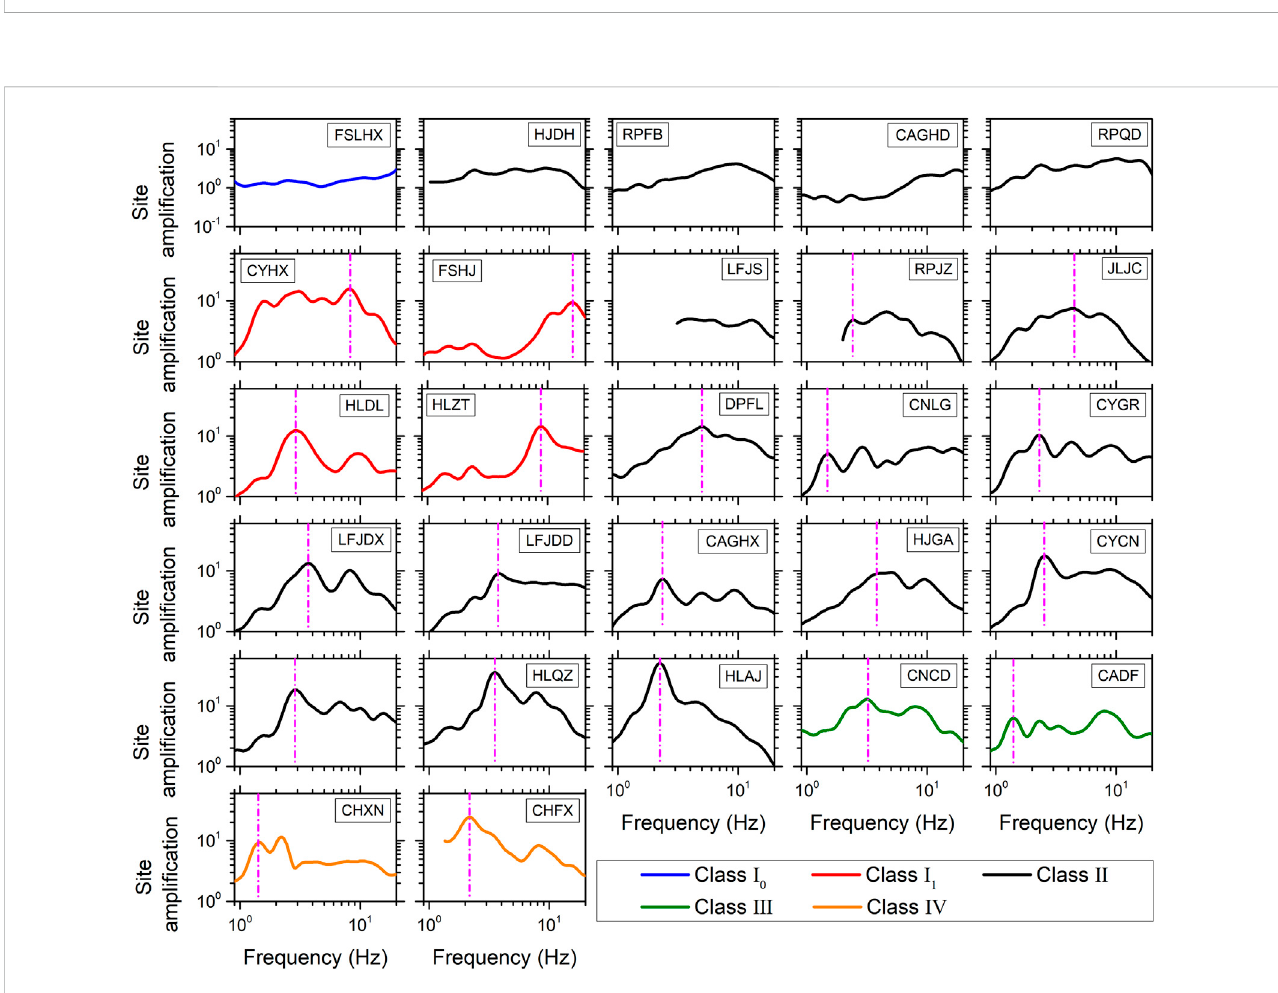
FIGURE 9 Inverted site responses of 27 stations employed in this